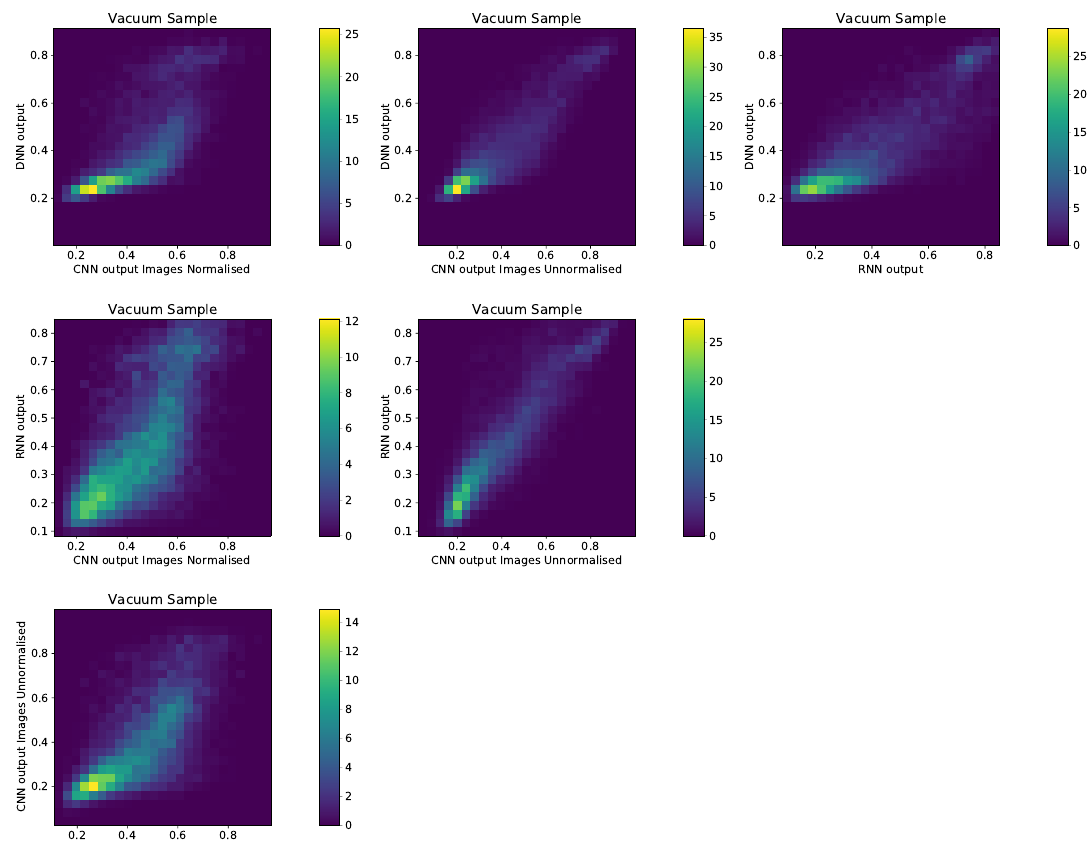
Figure 16 . Bi-dimensional distributions of the Deep Neural Network outputs for the Vacuum